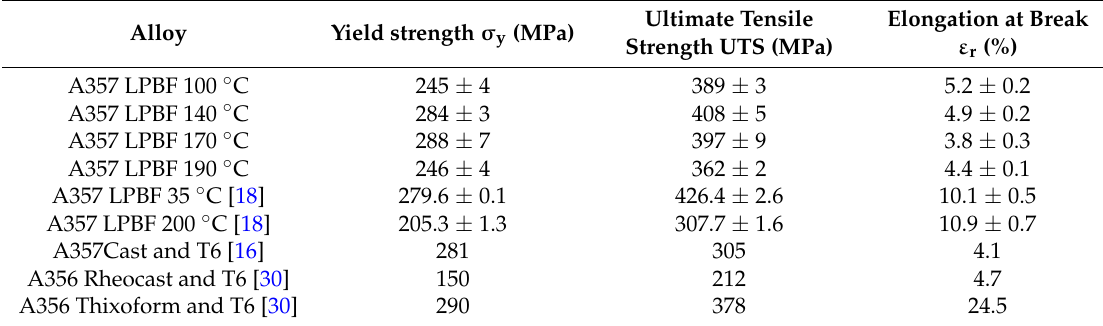
Table 3. Mechanical properties of the A357 samples built with different building platform temperatures.